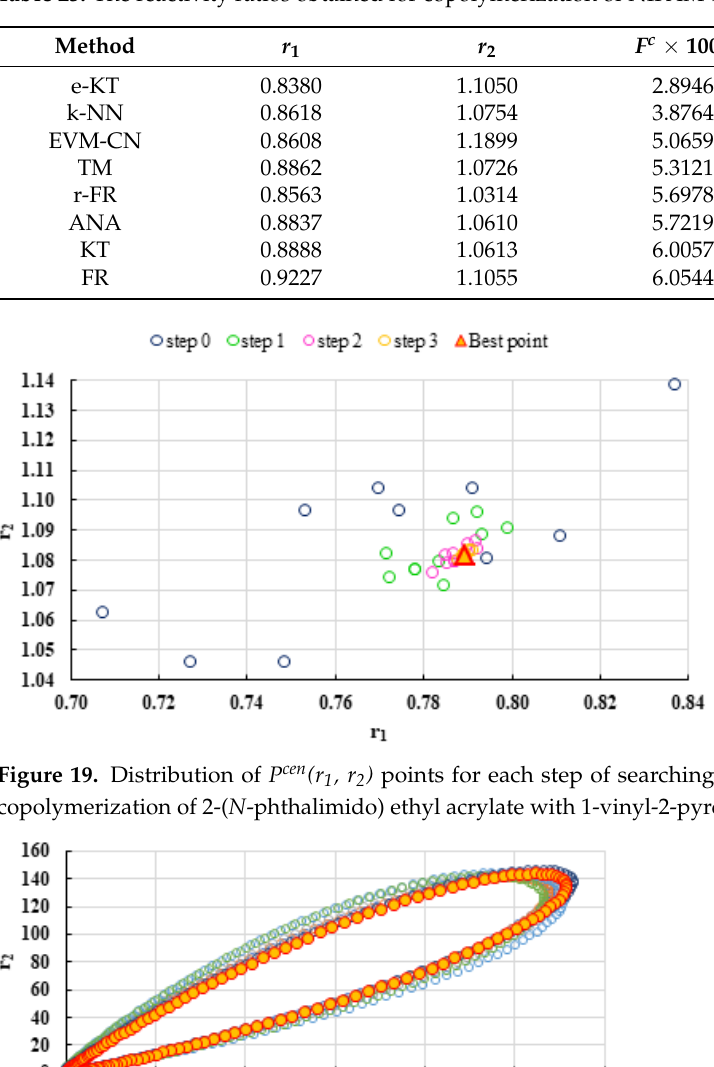
Table 23. The reactivity ratios obtained for copolymerization of NIPAM-NVP [41].